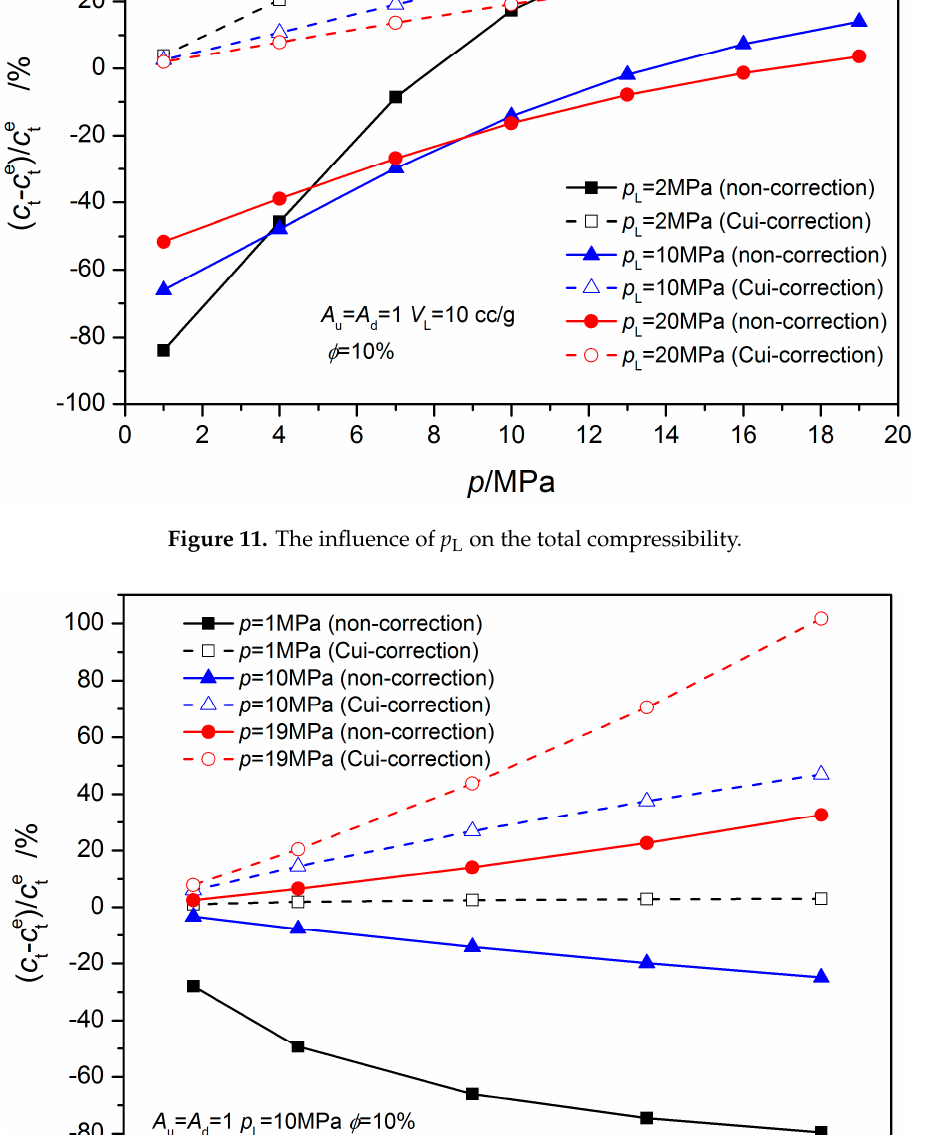
Figure 12. The influence of V L on the total compressibility.